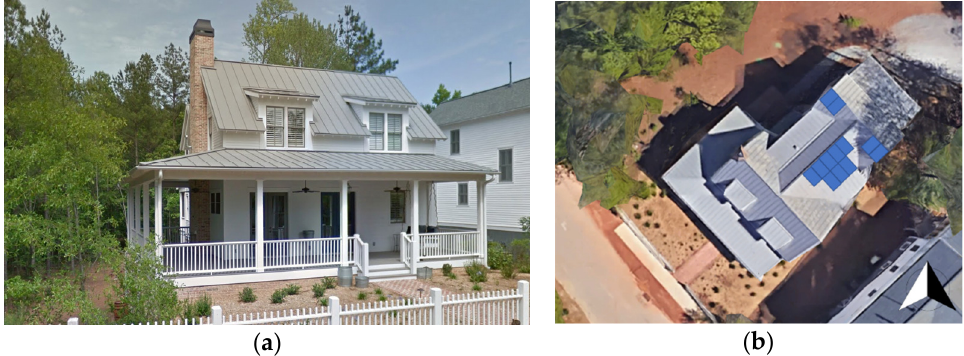
Figure 6. Building C in the Serenbe Community. ( a ) Front view (southwest); ( b ) roof view (PV covers 10% of the roof space). Source: modified from Google Maps 2021.